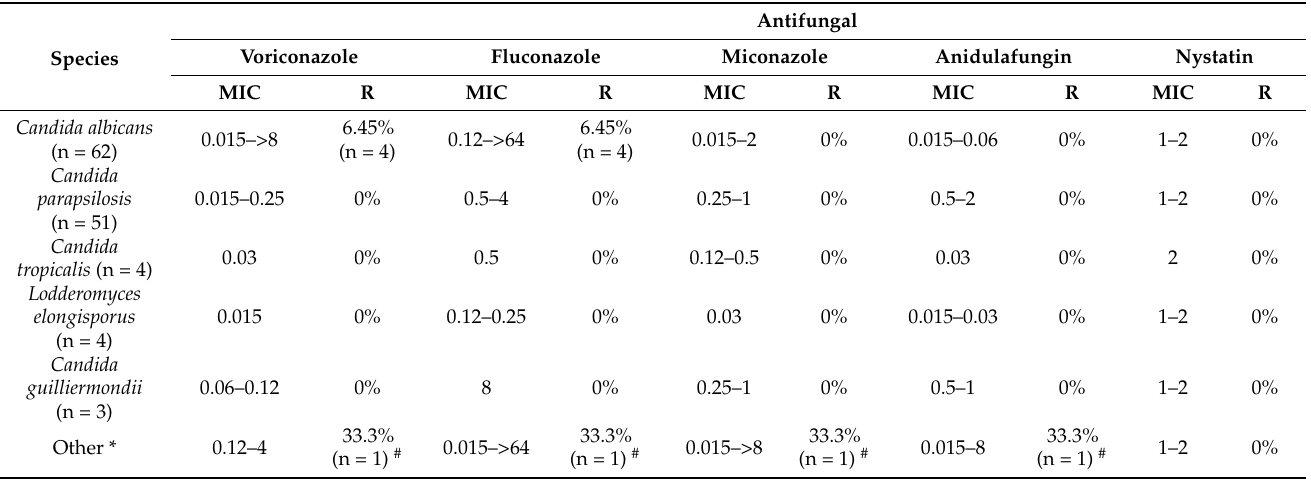
Table 4. Minimal inhibitory concentrations (MICs) and resistance (R) rates of species isolated from mother–child